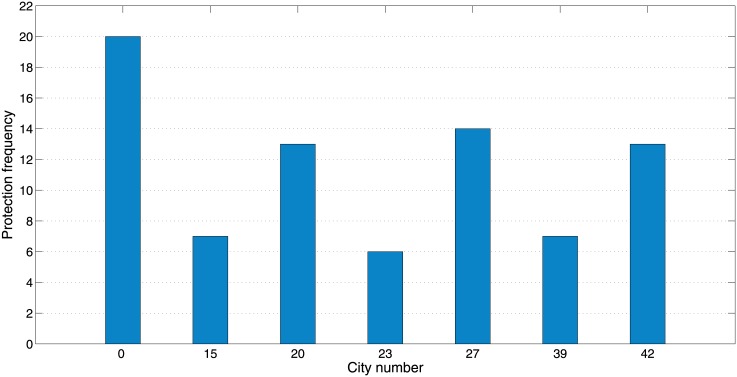
Frequency of opening a reliable facility for different sites.